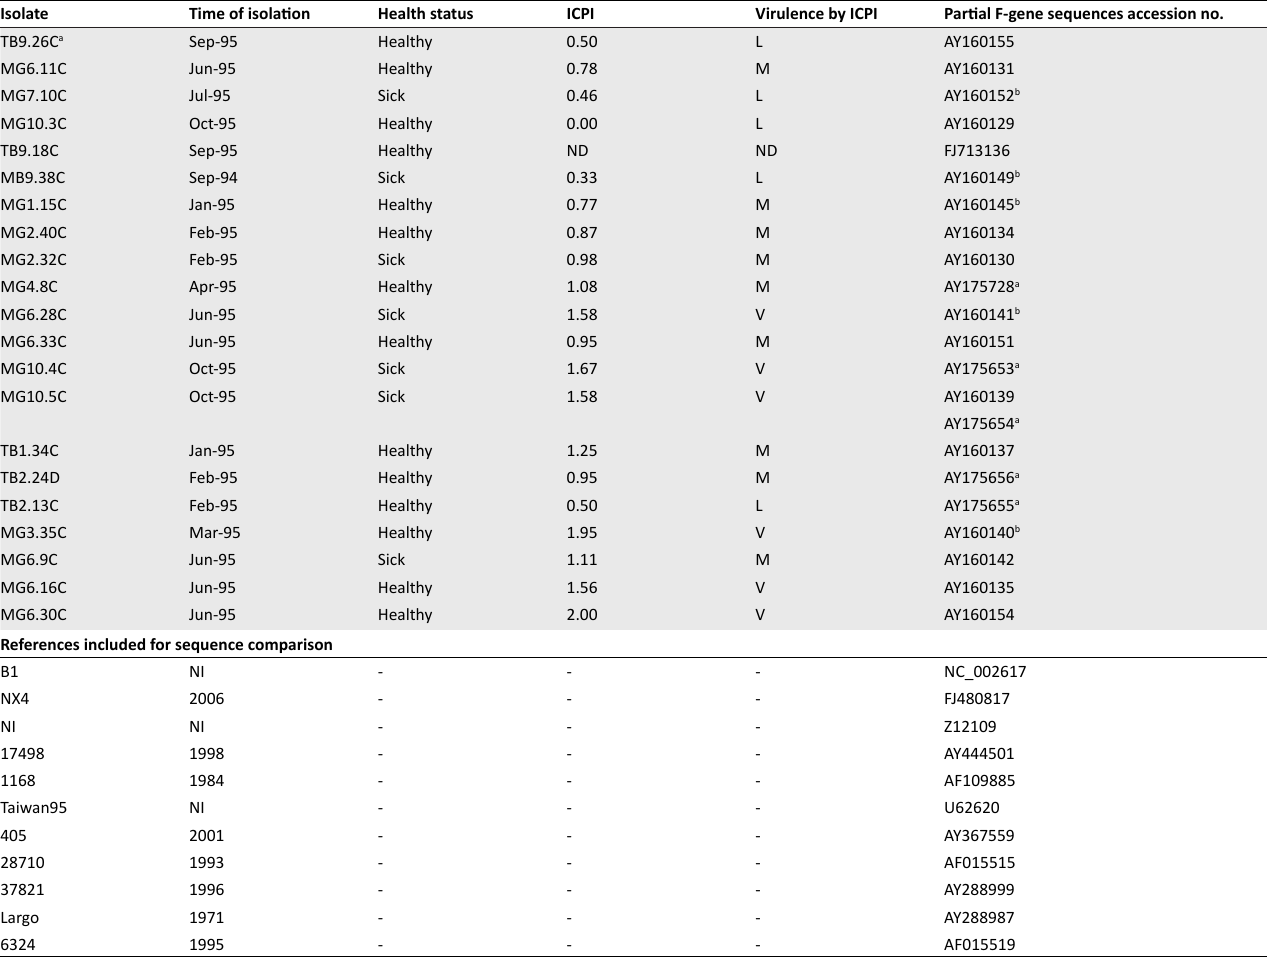
TABLE 1: List of Newcastle disease virus isolates investigated.